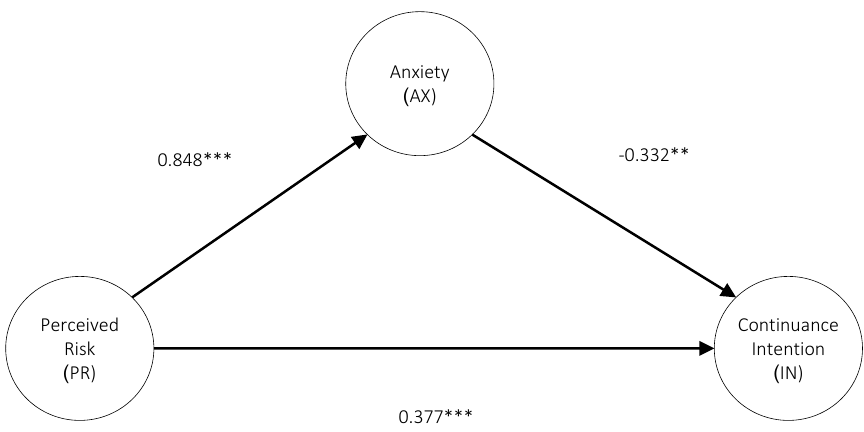
Figure 3. Structural equation